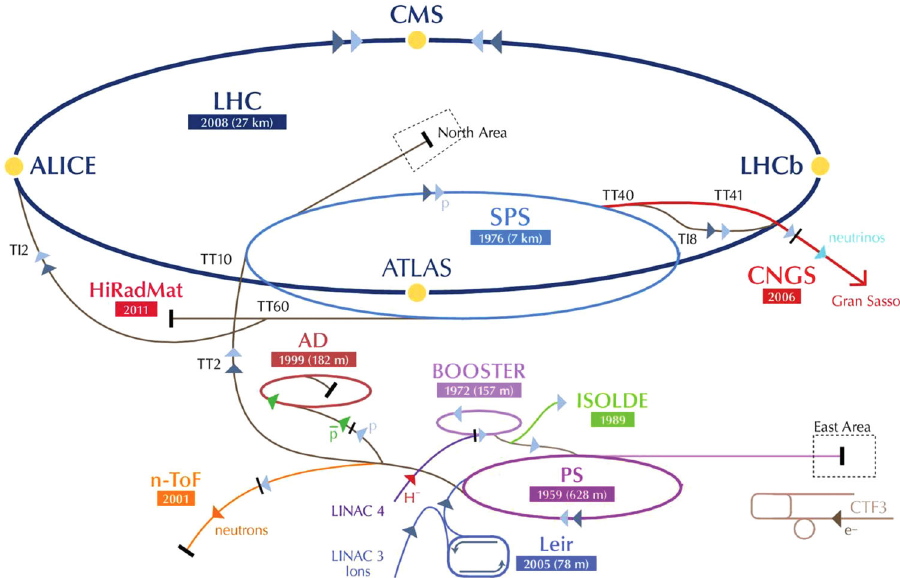
FIG. 4. Existing CERN accelerator complex with Large Hadron Collider (LHC), Super Proton Synchrotron (SPS), Proton Synchrotron (PS), Antiproton Decelerator (AD), Low Energy Ion Ring (LEIR), Linear Accelerators (LINAC), CLIC Test Facility (CTF3), CERN (cid:3) to Gran Sasso (CNGS), Isotopes Separation on Line (ISOLDE), and neutrons Time of Flight